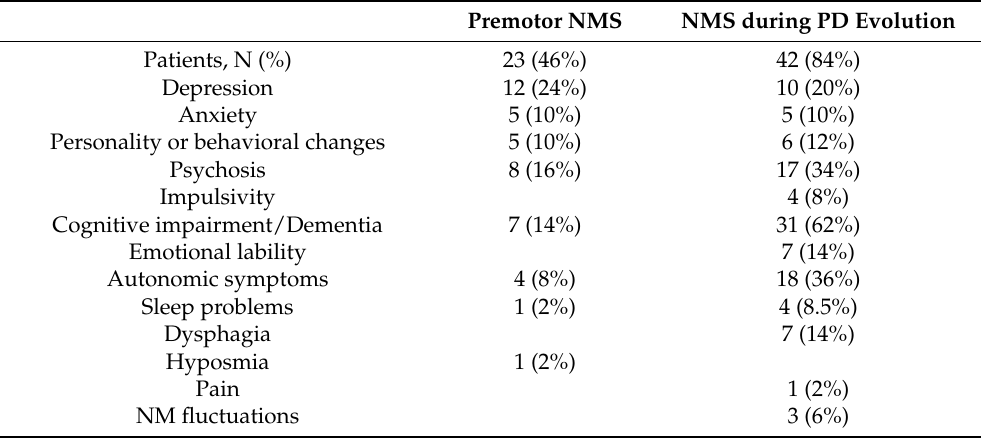
Table 2. NMS in patients with PLA2G6 -associated